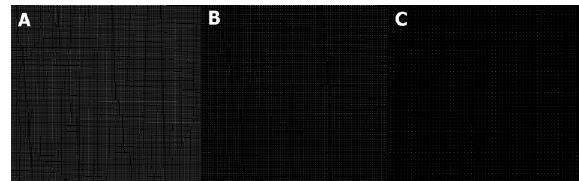
Fig ure 12. Point clouds of the test object, colour by classification acquire from a 20 m distance, with resolution 1/1 (A), 1/2 (B) and 1/4 (C)